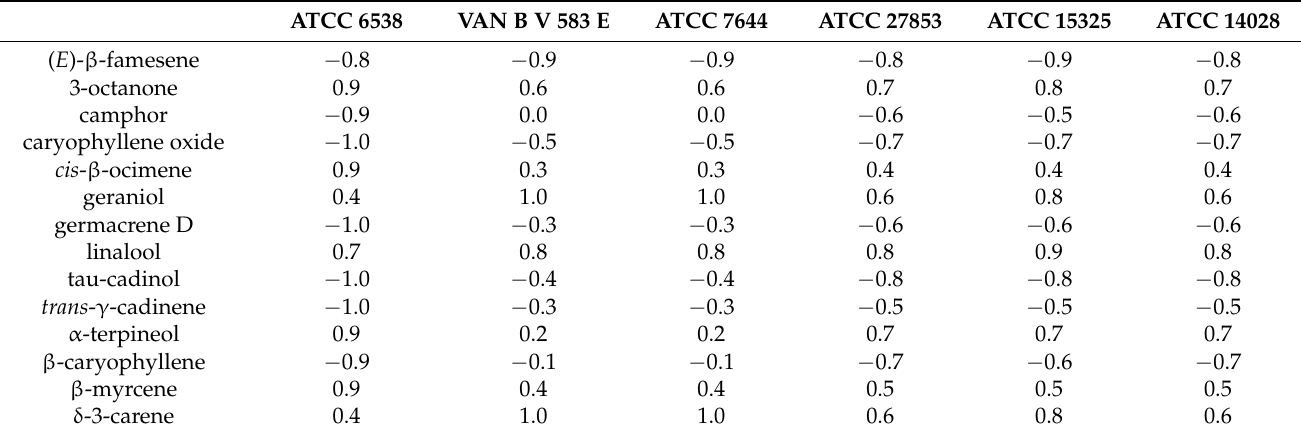
Table 6. Correlation coefficients of the MIC and the main compounds of lavender